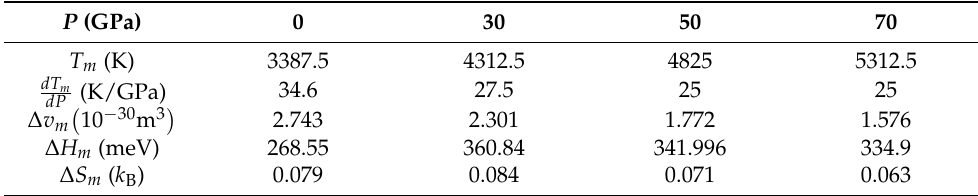
Table 9. Jumping of volume, and enthalpy and entropy at melting point (using the melting curve calculated by the SMM for the defective